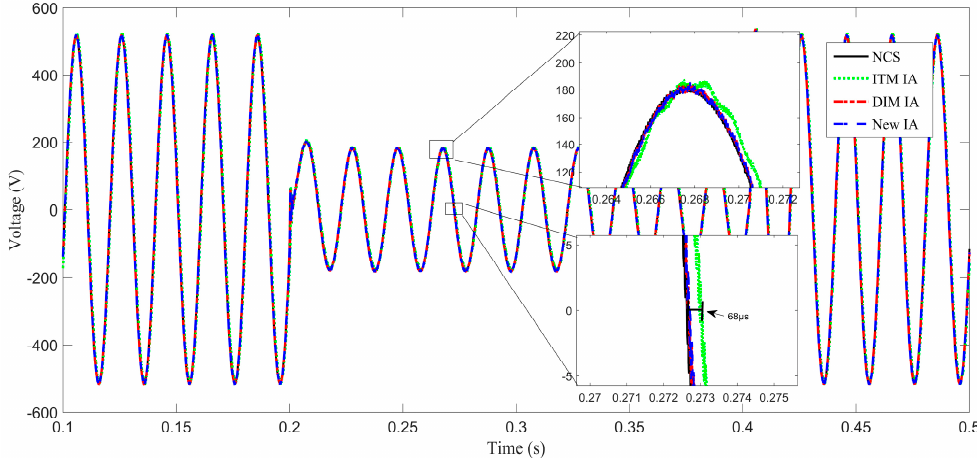
Figure 11. The voltage waveforms of power grid simulation branch in the DSS side of RITSS with the new IA.